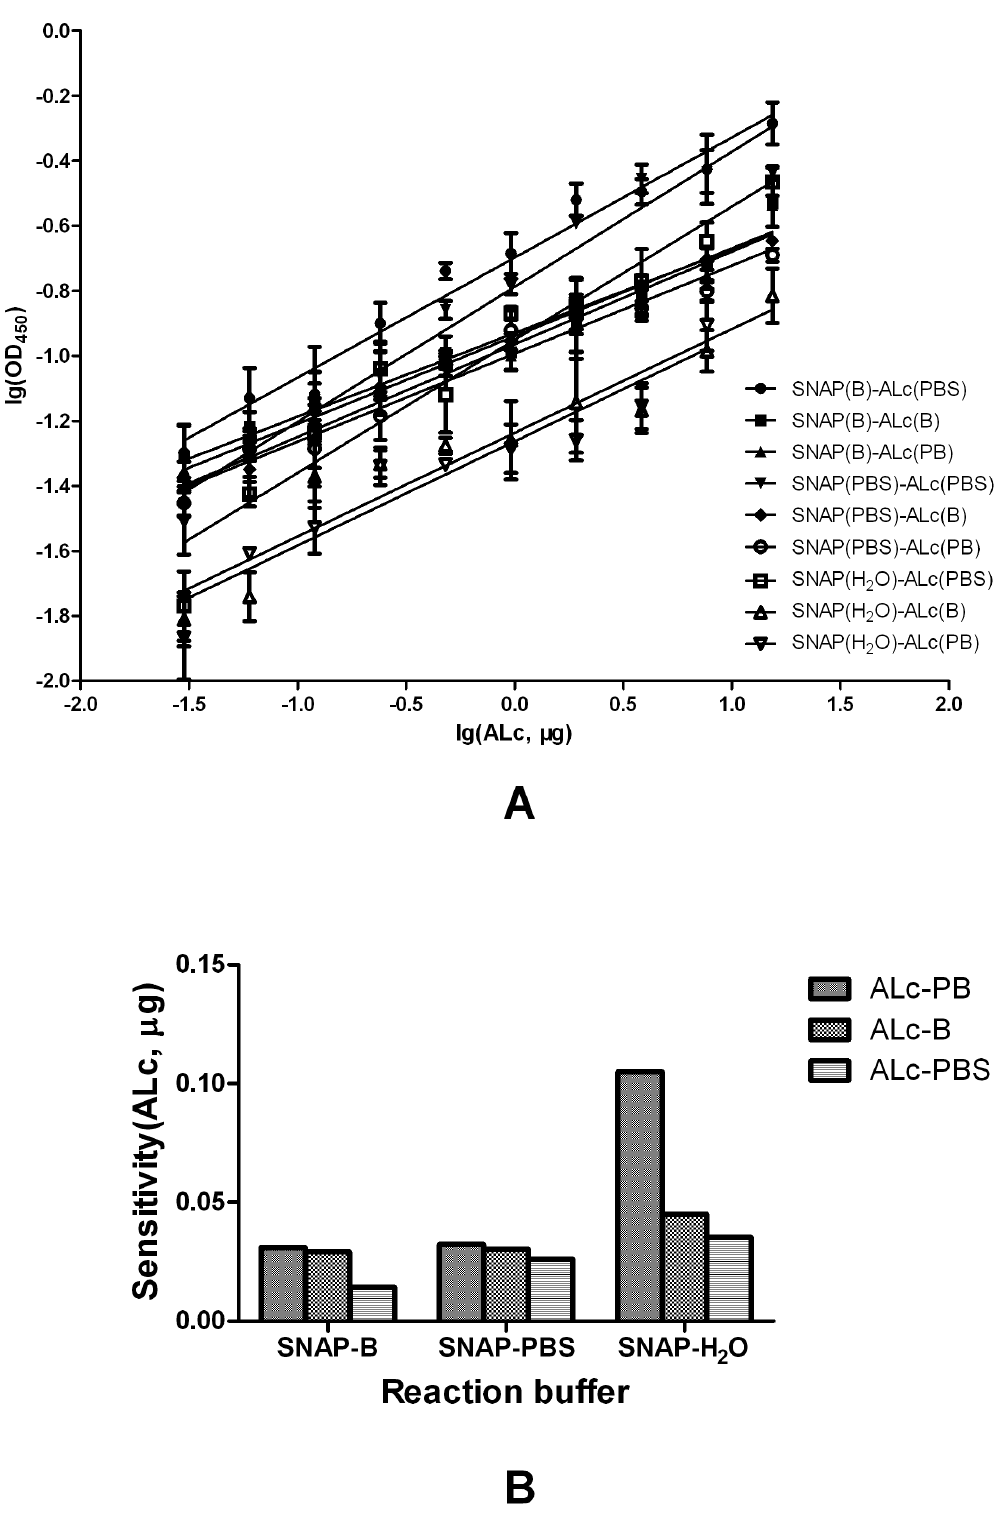
Figure 3. Effects of buffer in the ALc endopeptidase assay. A) The concentration–response relations between OD 450 and ALc with different buffer combinations. B buffer: 0.02 M Na 3 PO 4 , 0.5 M NaCl, 0.4 M imidazole, pH 7.4; PBS buffer: 0.008 M NaH 2 PO 4 , 0.002 M Na 2 HPO 4 , 0.145 M NaCl, pH 7.2; PB buffer: 0.008 M d NaH 2 PO 4 , 0.002 M Na 2 HPO 4 , pH 7.2. B) Sensitivity of endopeptidase assay in different buffer combinations.